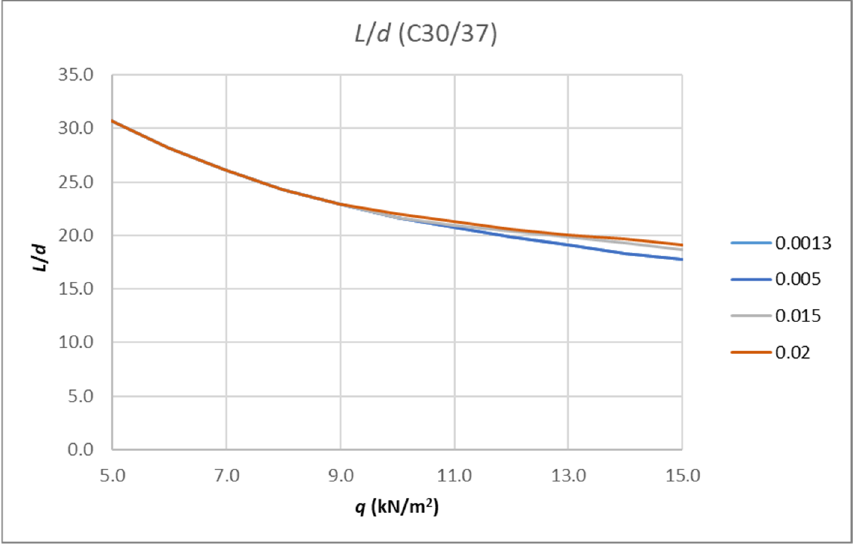
Figure 8. Results of analysis-limit span to depth ratio depending on amount of load for fixed value of concrete class and different reinforcement ratio.